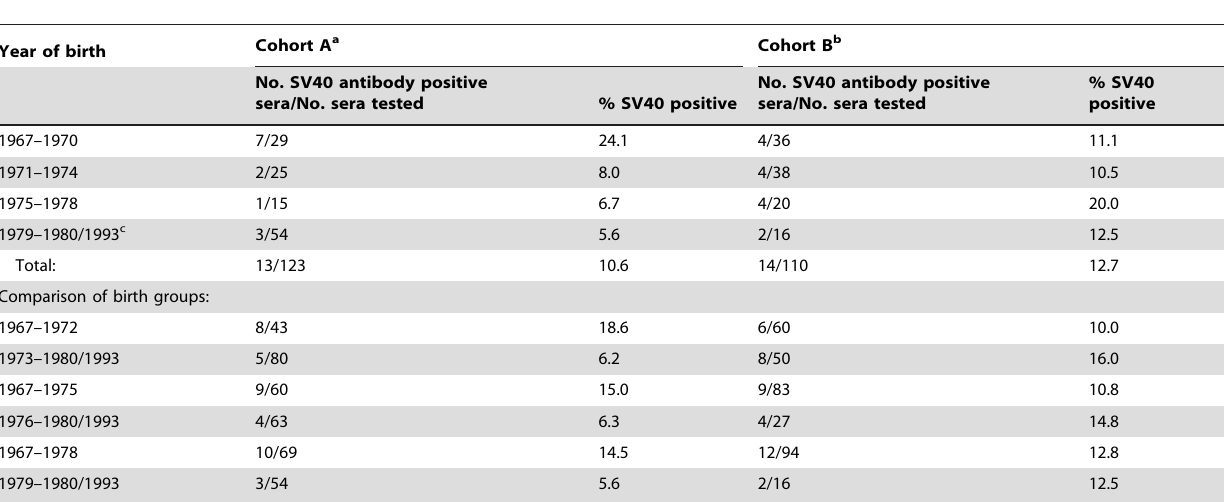
Table 3. Age distribution of SV40 antibodies in pregnant